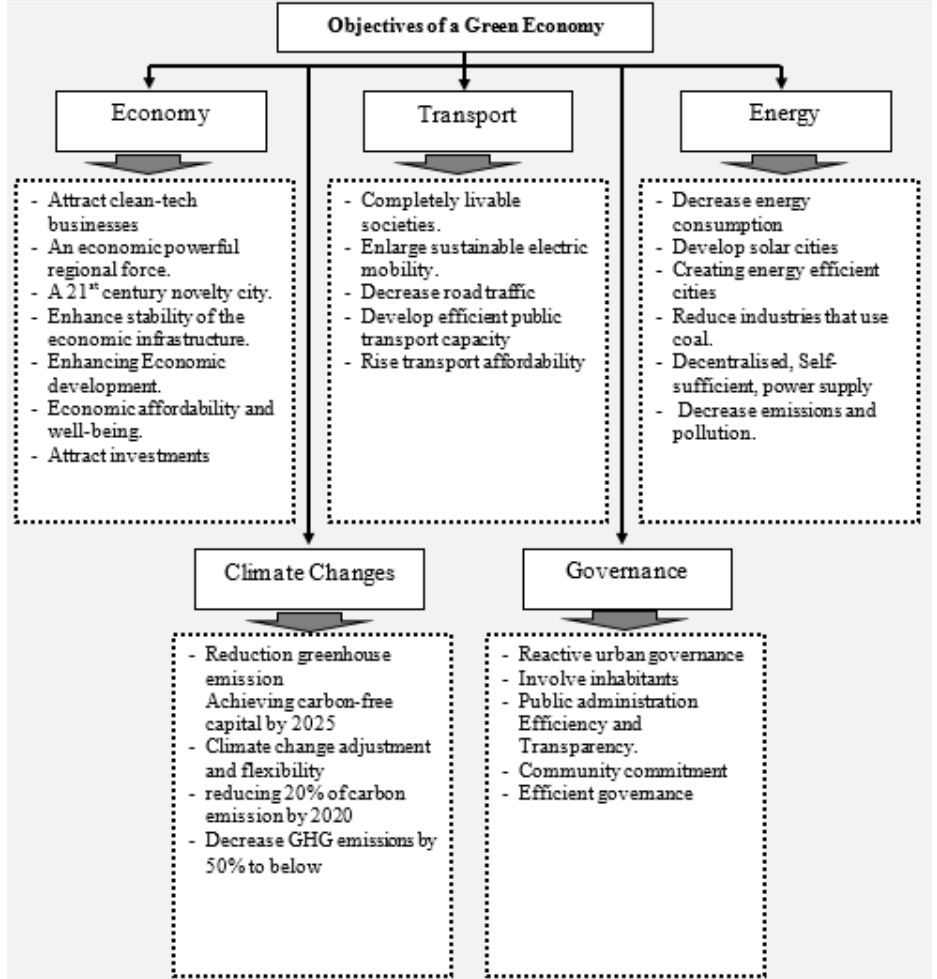
Figure 1. The objectives of a green economy Reference: The author after Kasztelan (2017), Fedrigo-Fazio(2012) and UNEP